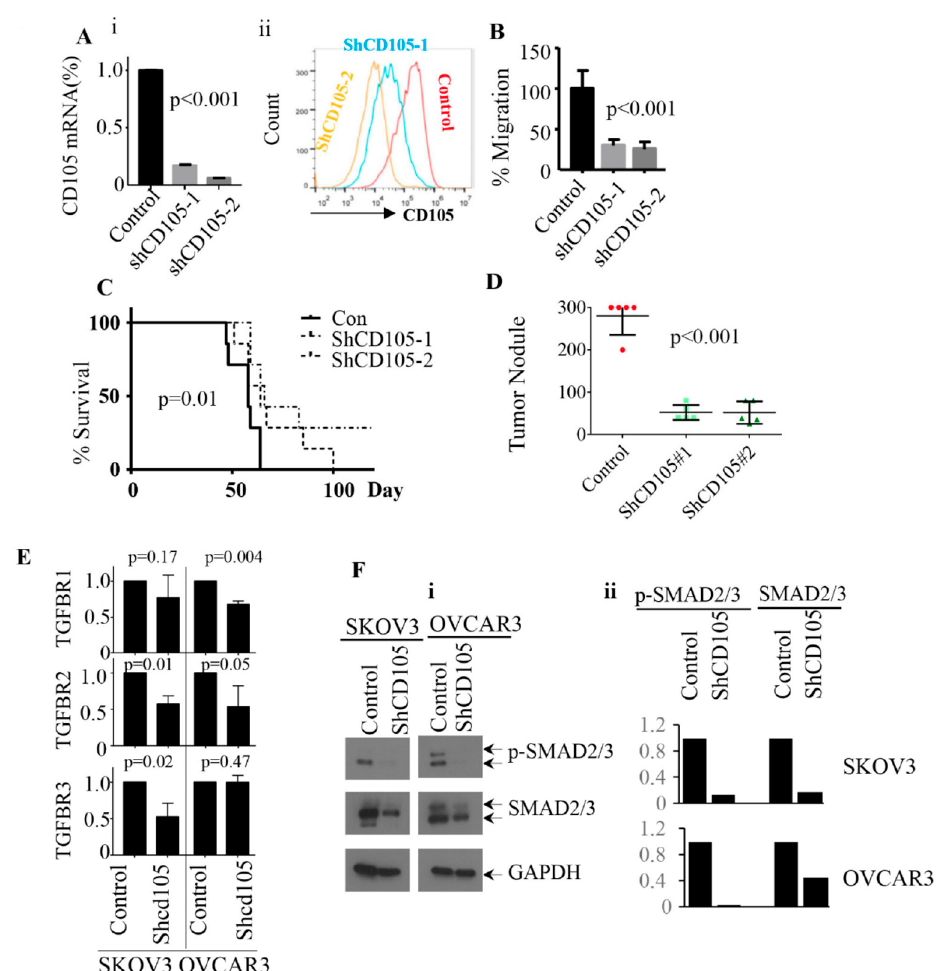
Figure 5. CD105 knockdown reduced ovarian metastasis and improved survival in mouse models of high-grade serous ovarian cancers (HGSC) ovarian cancer cells. ( A ) i-ii qRT-PCR and flow cytometry analysis of CD105 mRNA and protein expression in control, shCD105-1, and shCD105-2 OVCAR3 cells. CD105 mRNA in control cells was set as 1 after normalization with HPRT. The values are the means ± SD from three independent experiments ( p < 0.001). ( B ) Summary of average cell migration potential, from three independent experiments, of CD105-knockdown cells relative to control cells (control cell migration defined as 100%). ( C ) Kaplan–Meier survival curves of mice injected with control, shCD105-1, or shCD105-2 ( n = 7 each) bearing IV-injected OVCAR3 ovarian tumor cells. ( D ) Summary of intra-abdominal tumor nodules in mice intraperitoneally injected with control and CD105-knockdown cells ( n = 5 per group, p < 0.001). For quantification, tumor nodule numbers over 300 were estimated as 300. ( E ) mRNA expression of the indicated TGF- β receptors in control and CD105-knockdown SKOV3 and OVCAR3 cells; expression was defined as 1 after normalization with HPRT. The values are the means ± SD from three independent experiments ( p values are as indicated) ( F ) (i) Western blot analysis of phosphorylated SMAD2 / 3 (p-SMAD2 / 3) and total SMAD2 / 3 in control and CD105 knockdown SKOV3 and OVCAR3 cells and (ii) densitometry analysis of Western blot using Image J. Expression value of SMAD2 / 3 and (p-SMAD2 / 3) in control cells were set as 1 after normalization with the corresponding GAPDH